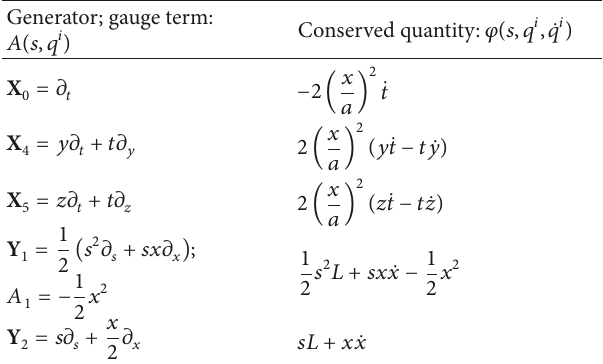
Table 16: Conserved quantities corresponding to each Noether symmetry.